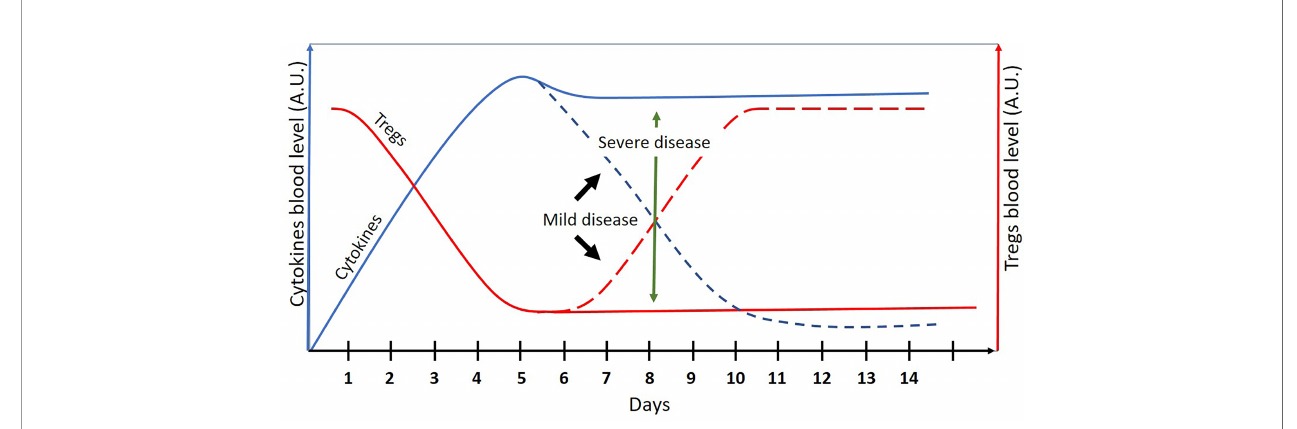
FIGURE 1 | A schematic presentation of cytokines and Treg cells blood levels (arbitrary units) in COVID-19 patients as a function of time (days). The dashed lines represent the mild disease. Mild COVID-19 may be regarded as an acute and self-resolving in fl ammation. Severe COVID-19 may be regarded as “ low Treg ” chronic in fl ammation where the binary model of chronic diseases can be